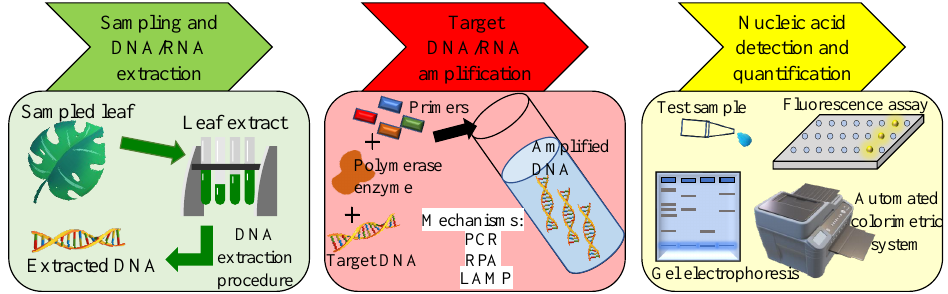
Figure 3. General steps involved in nucleic acid amplification-based phytopathogen